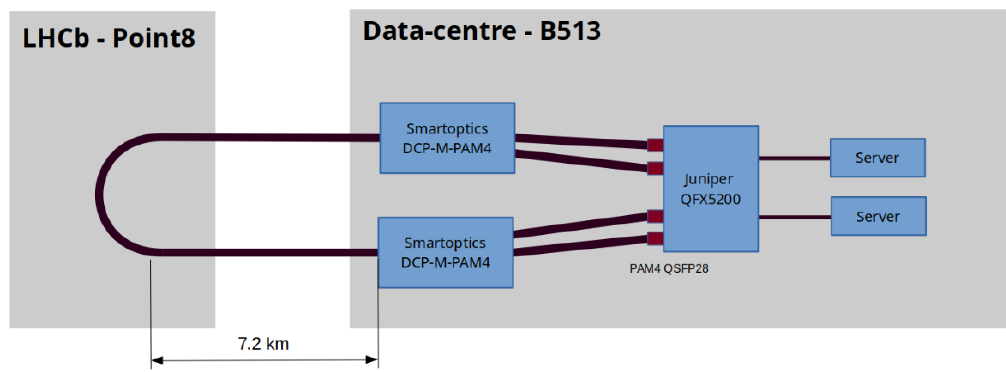
Figure 7. DWDM PAM-4 test